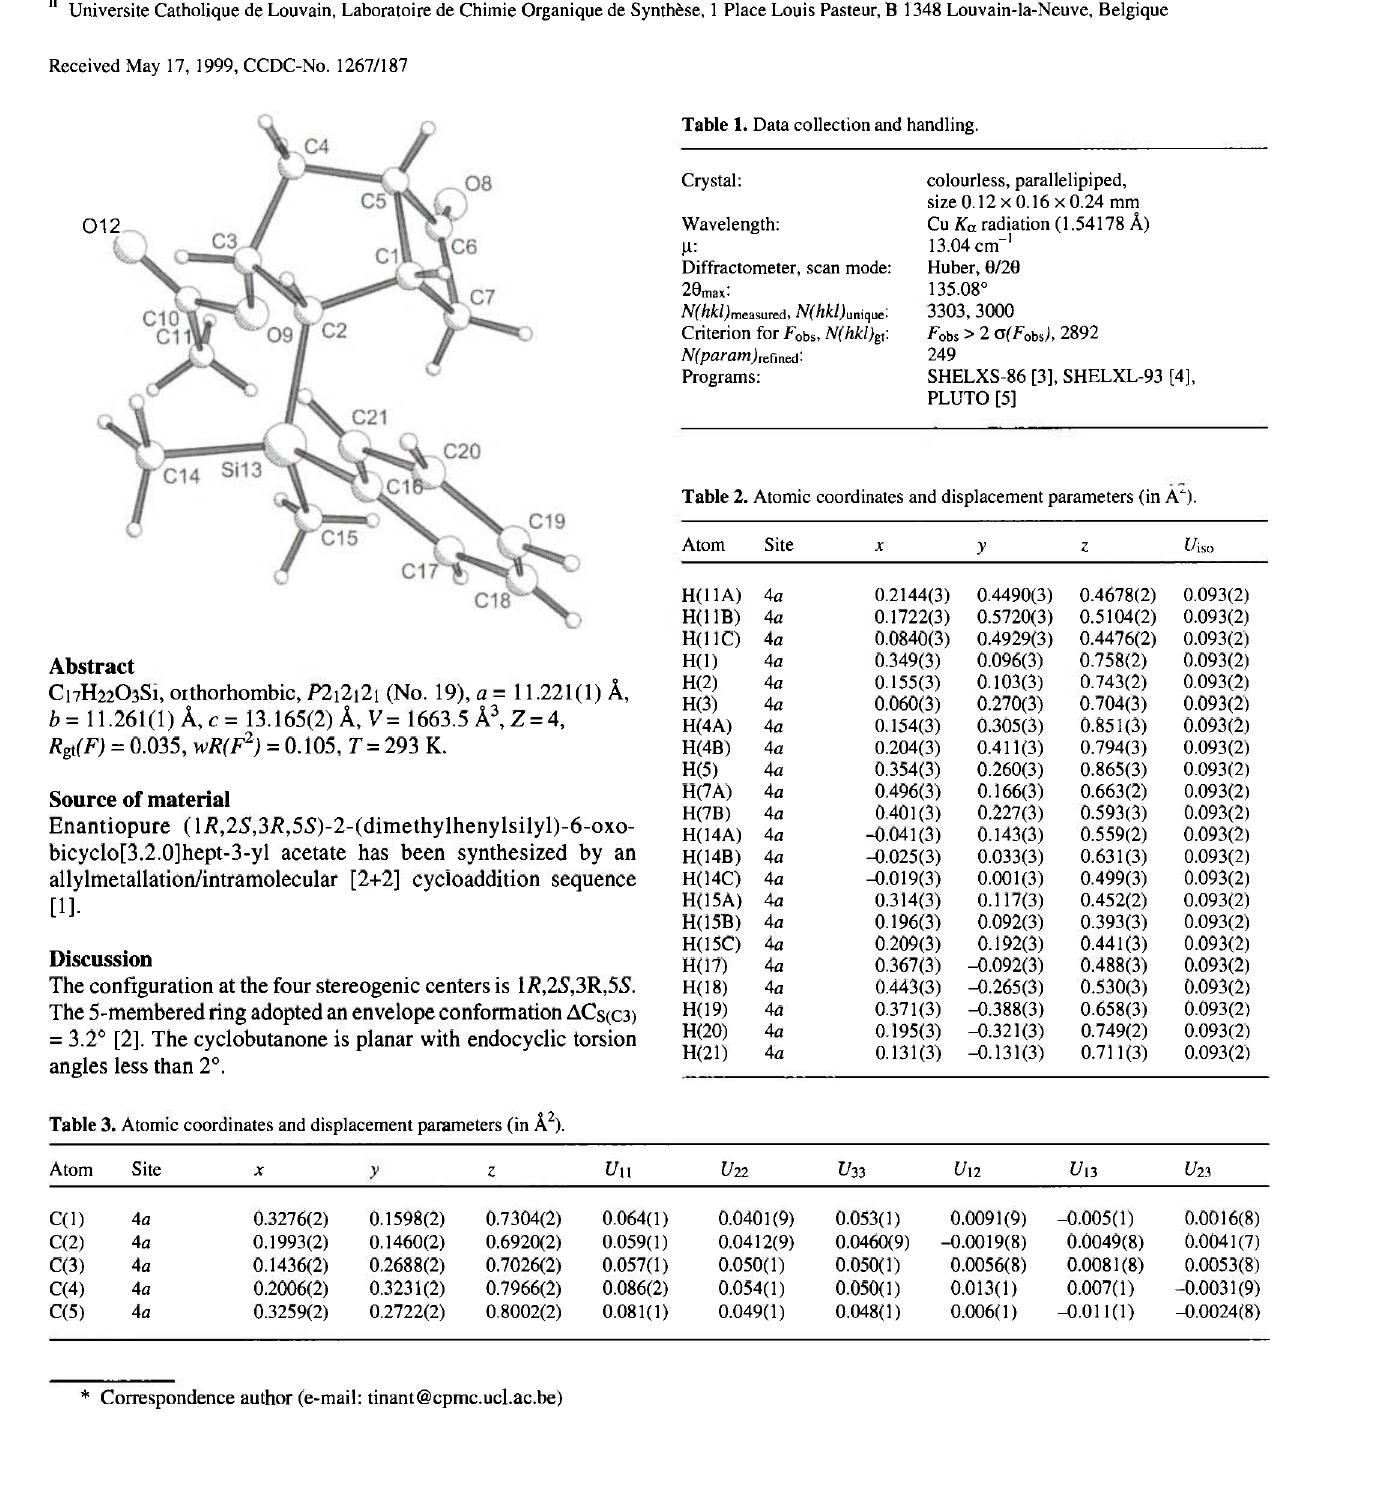
Table 1. Data collection and handling.